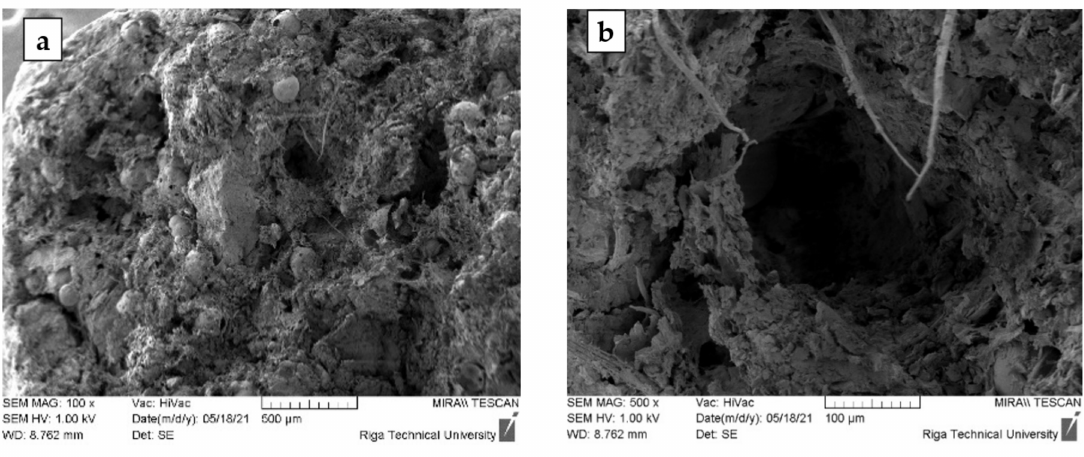
Figure 6. Granules with a composition of 5-90-5 SEM images at × 100 ( a ) and × 500 ( b ) magnification.